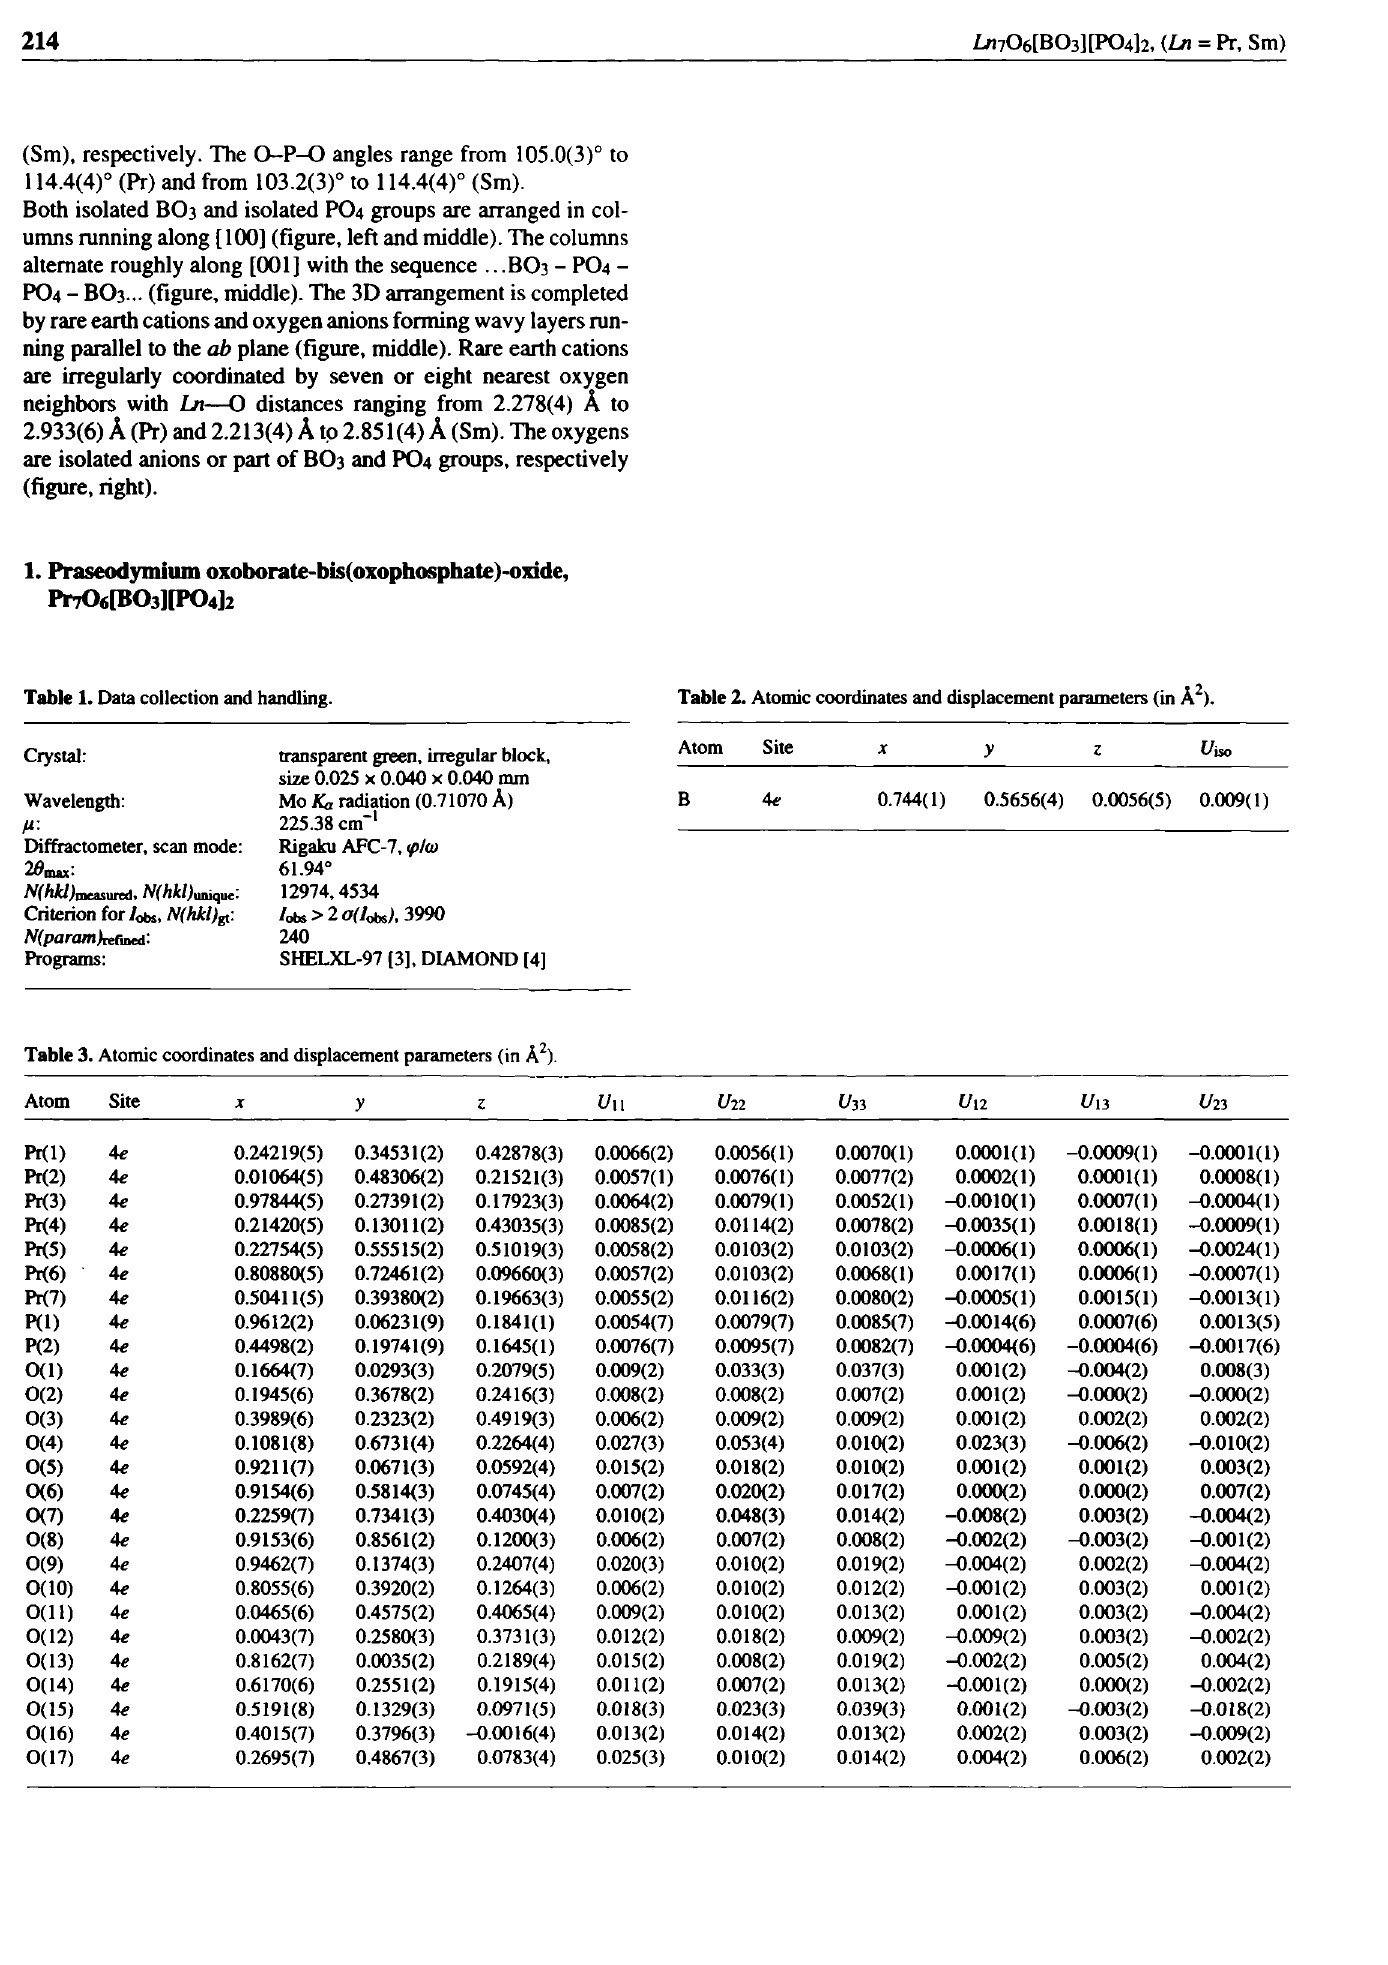
Table 1. Data collection and handling. Table 2. Atomic coordinates and displacement parameters (in A 2 ).